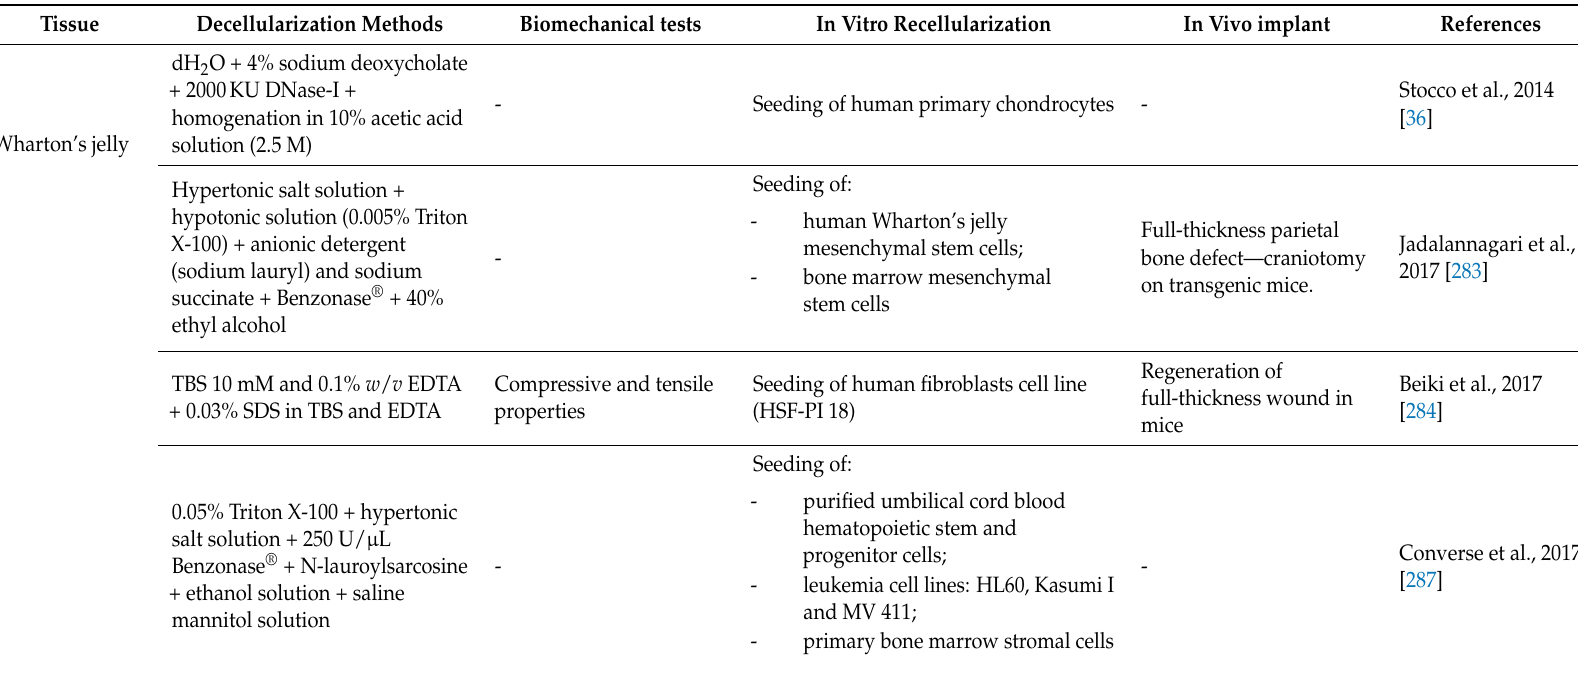
Table 11. Wharton’s jelly. Decellularization techniques, biomechanical tests, recellularization methods, and in vivo implant of human Wharton’s jelly extracellular